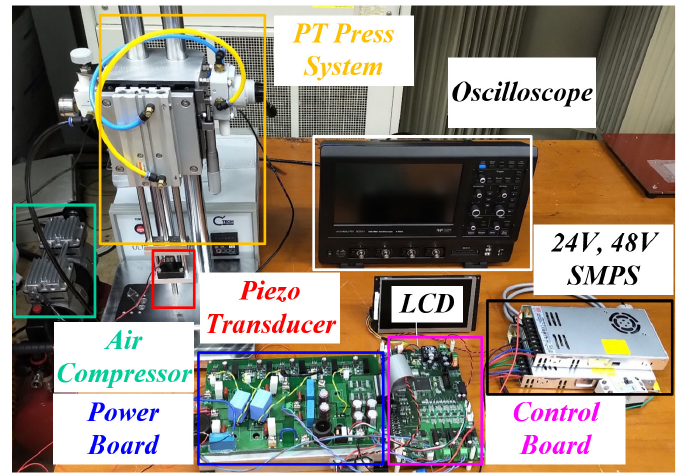
Figure 19. Experimental environment and configuration.